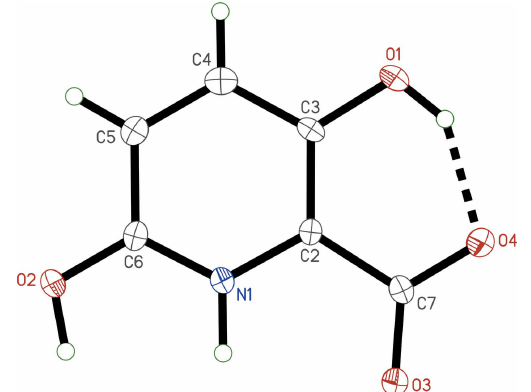
Figure 4 An ellipsoid (50% probability) plot of the asymmetric unit of II with the intramolecular hydrogen bond shown as a thick dashed